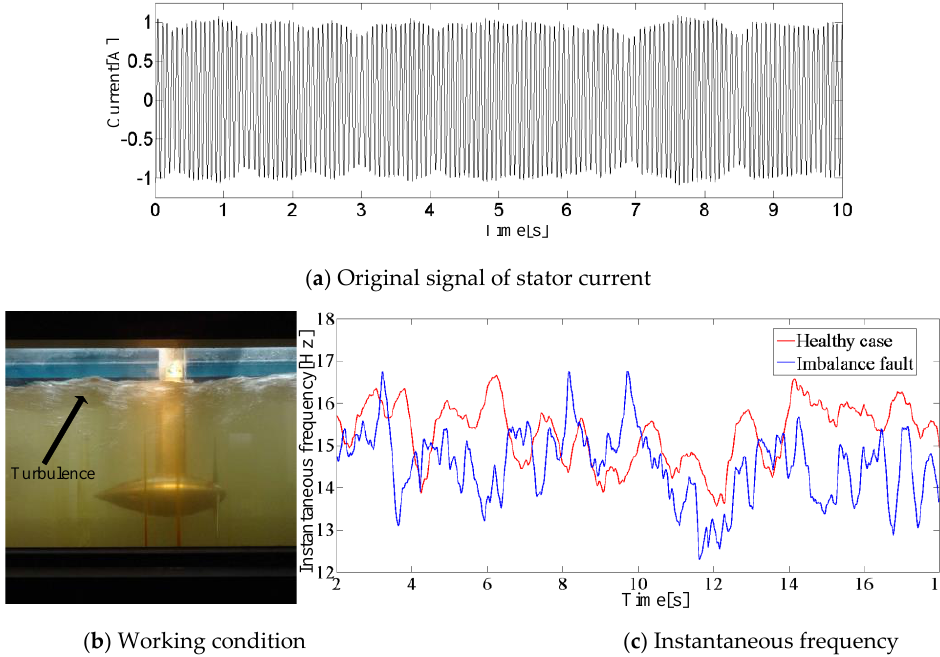
Figure 11. MCT strong interference working condition.